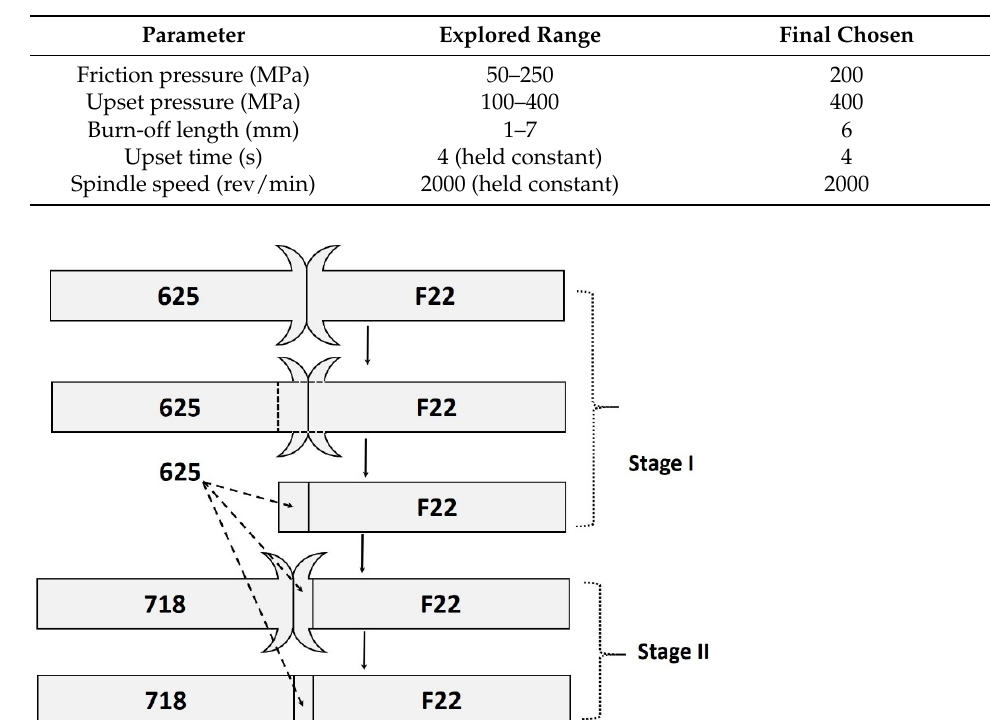
Table 2. Welding parameters.